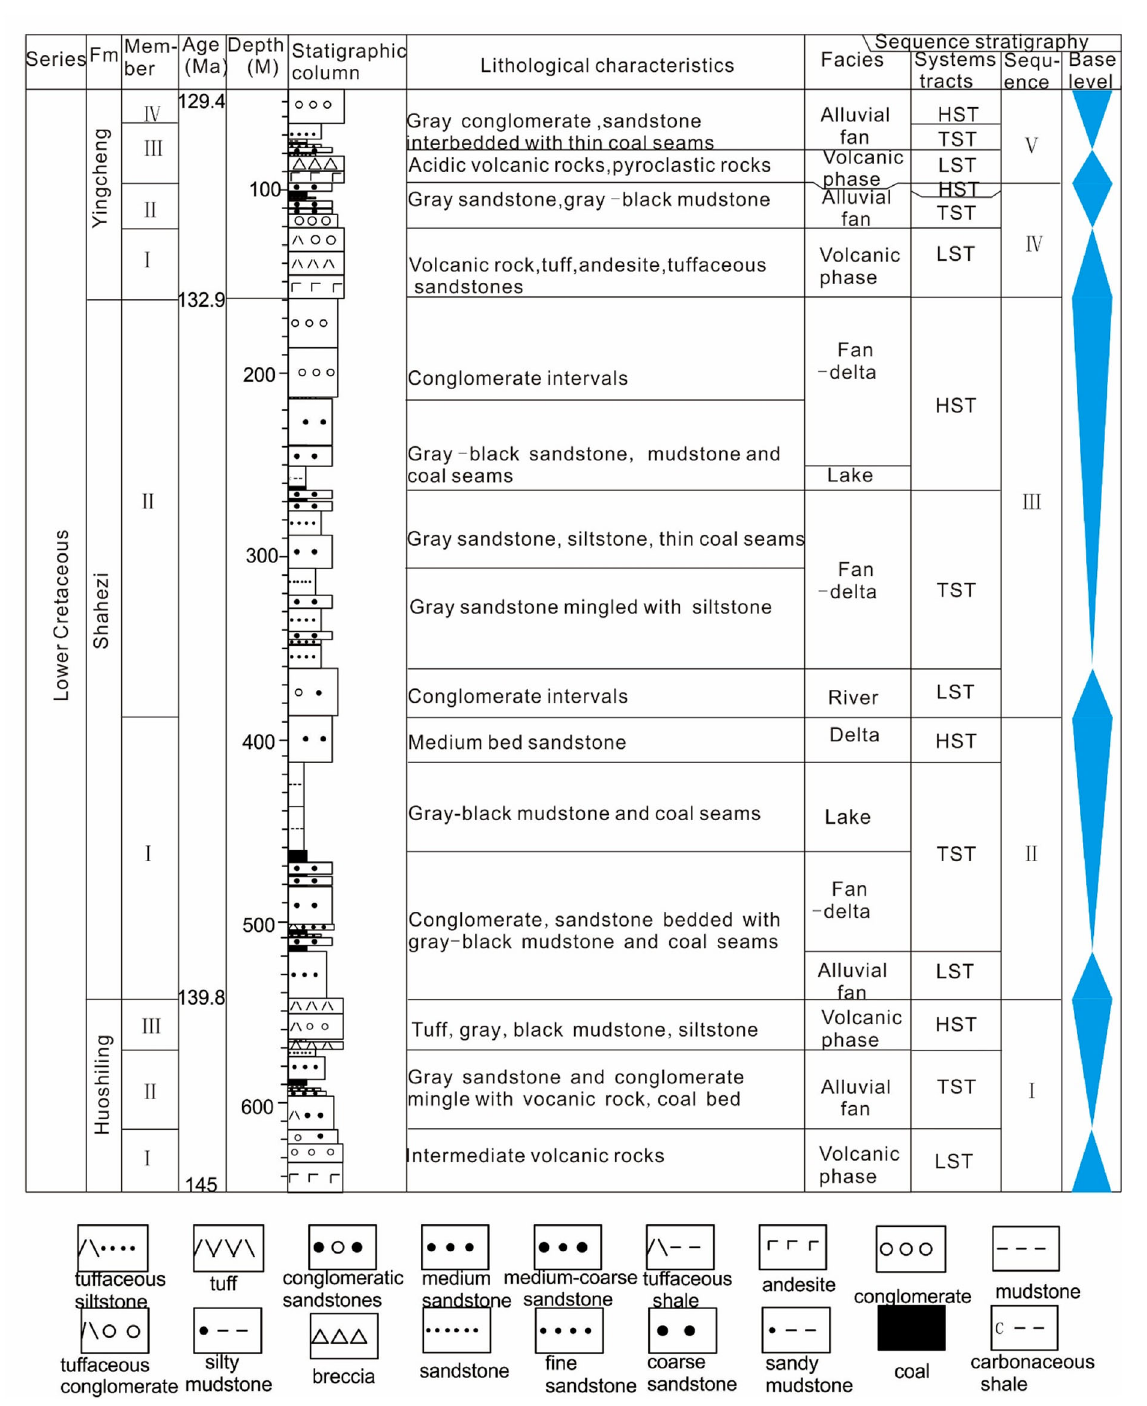
Fig. 2 Cross sections showing sequence stratigraphic framework of the Early Cretaceous coal-bearing strata in the east margin of Songliao